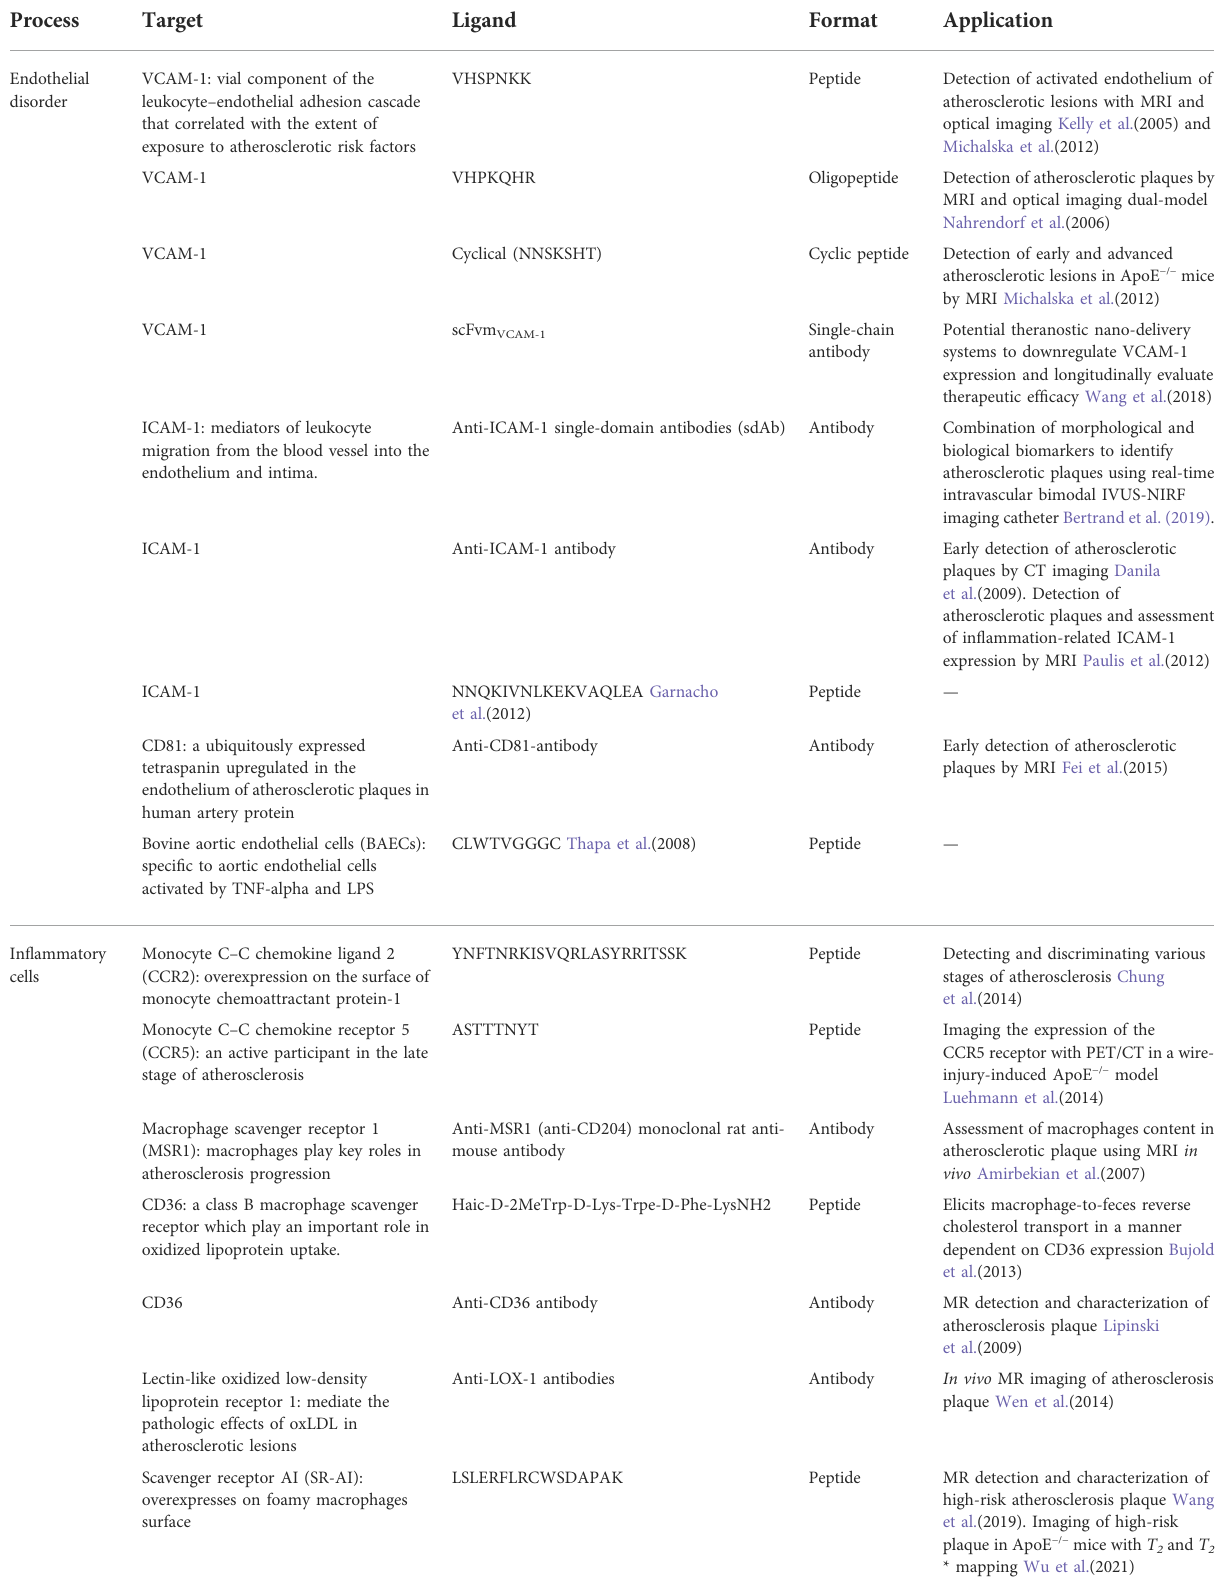
TABLE 2 Diversity of current ligand – receptor